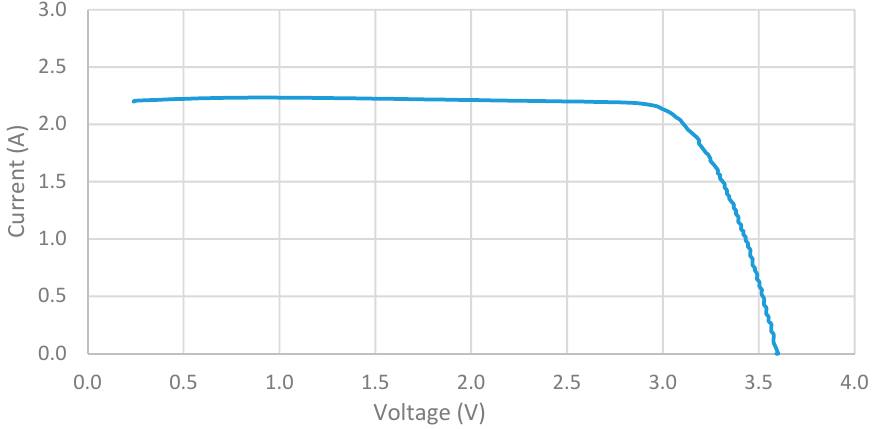
Figure A9. IV curve for receiver 5 after being exposed to all testing rounds